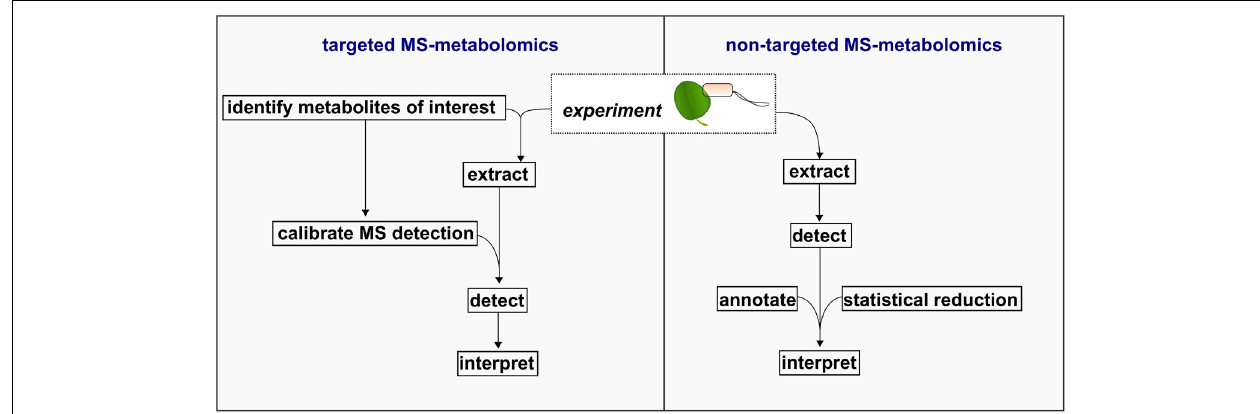
FIGURE 2 | Schematic of targeted and non-targeted MS-metabolomics